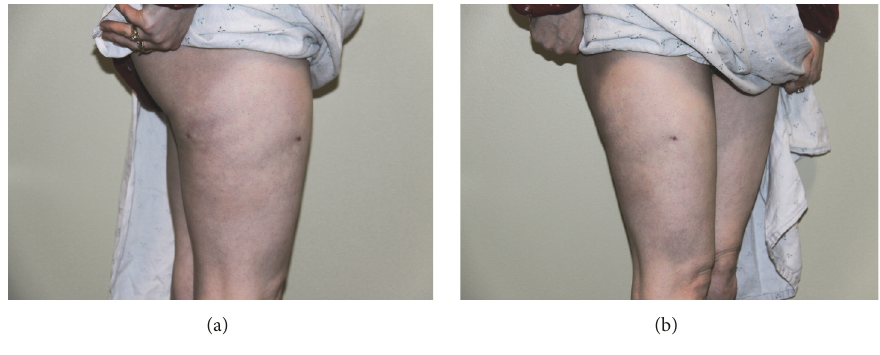
Figure 3: (a) Postop lateral. (b) Postop